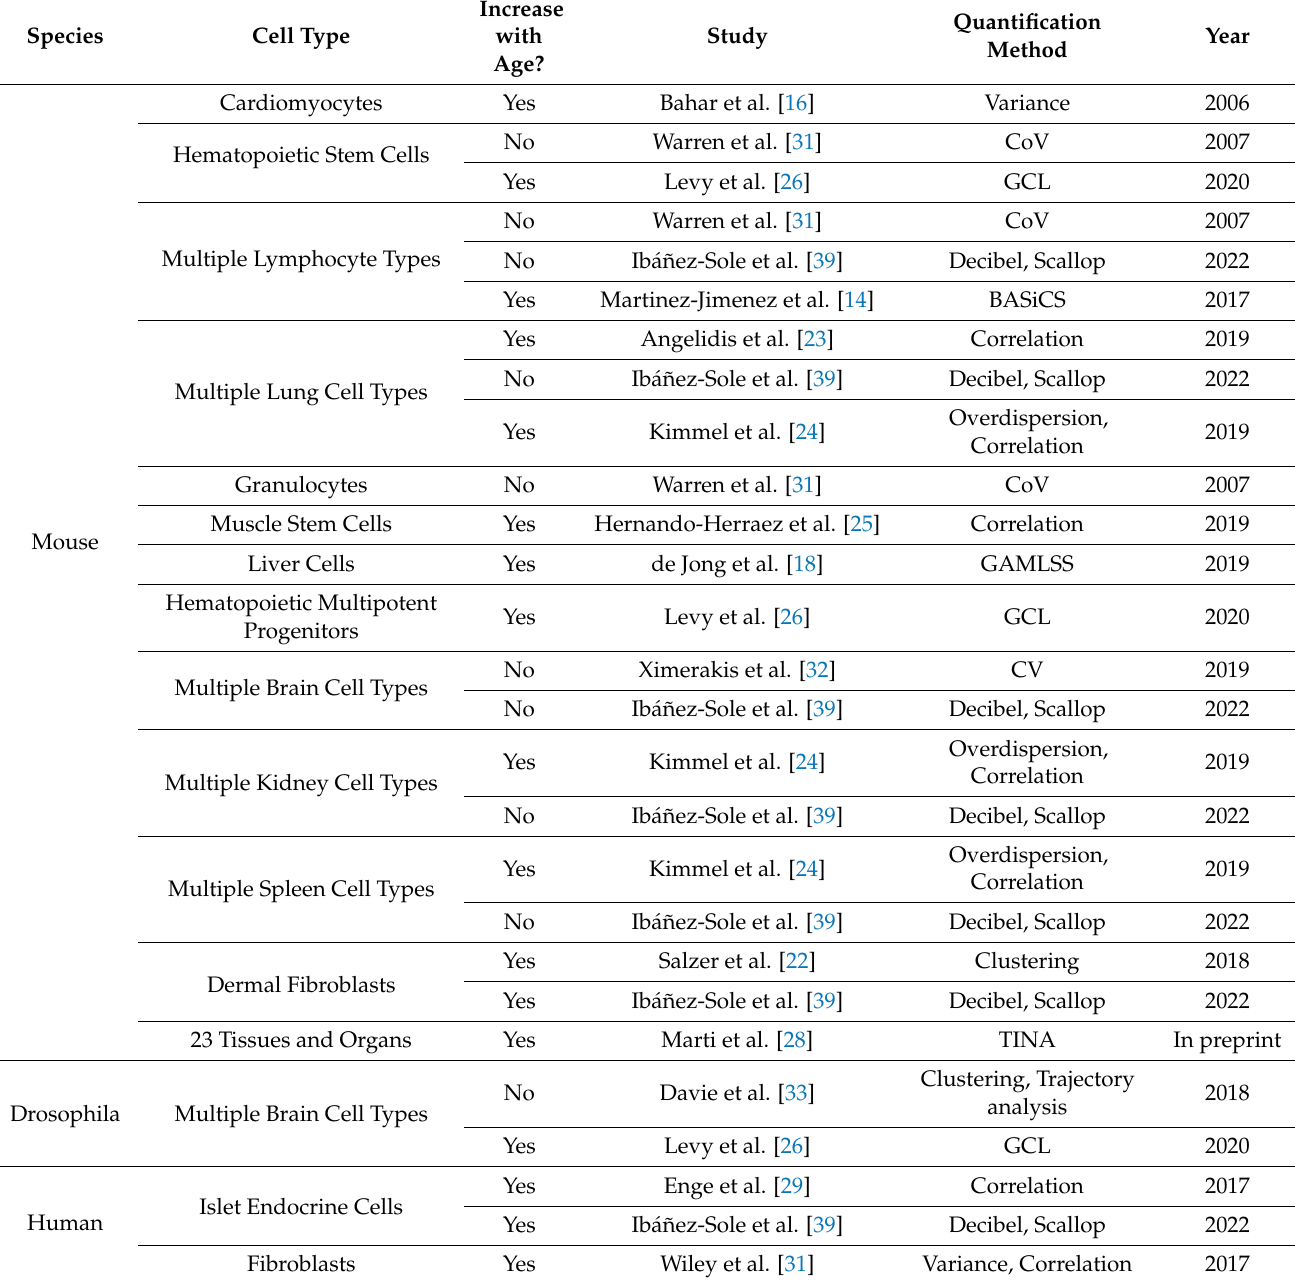
Table 1. A summary of studies about transcriptional noise in